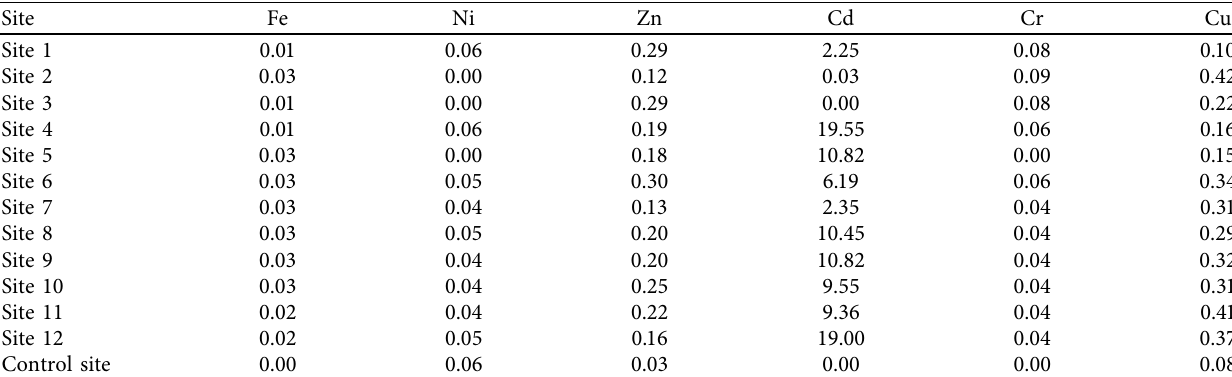
Figure 7: Concentration of heavy metals in Jimson weed. (a) Cd; (b) Cr; (c) Cu; (d) Ni; (e) Fe; and (f) Zn. Table 3: Transfer coefficient of heavy metals in Jimson